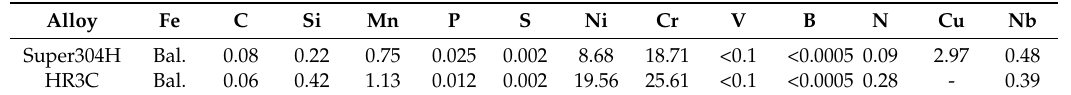
Table 1. Compositions of Super304H and HR3C steels (wt%).